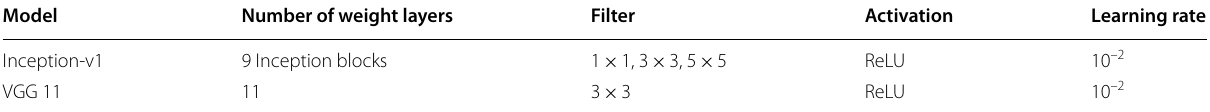
Table 9 An overview of two classical CNNs-based models used for comparative analysis Model